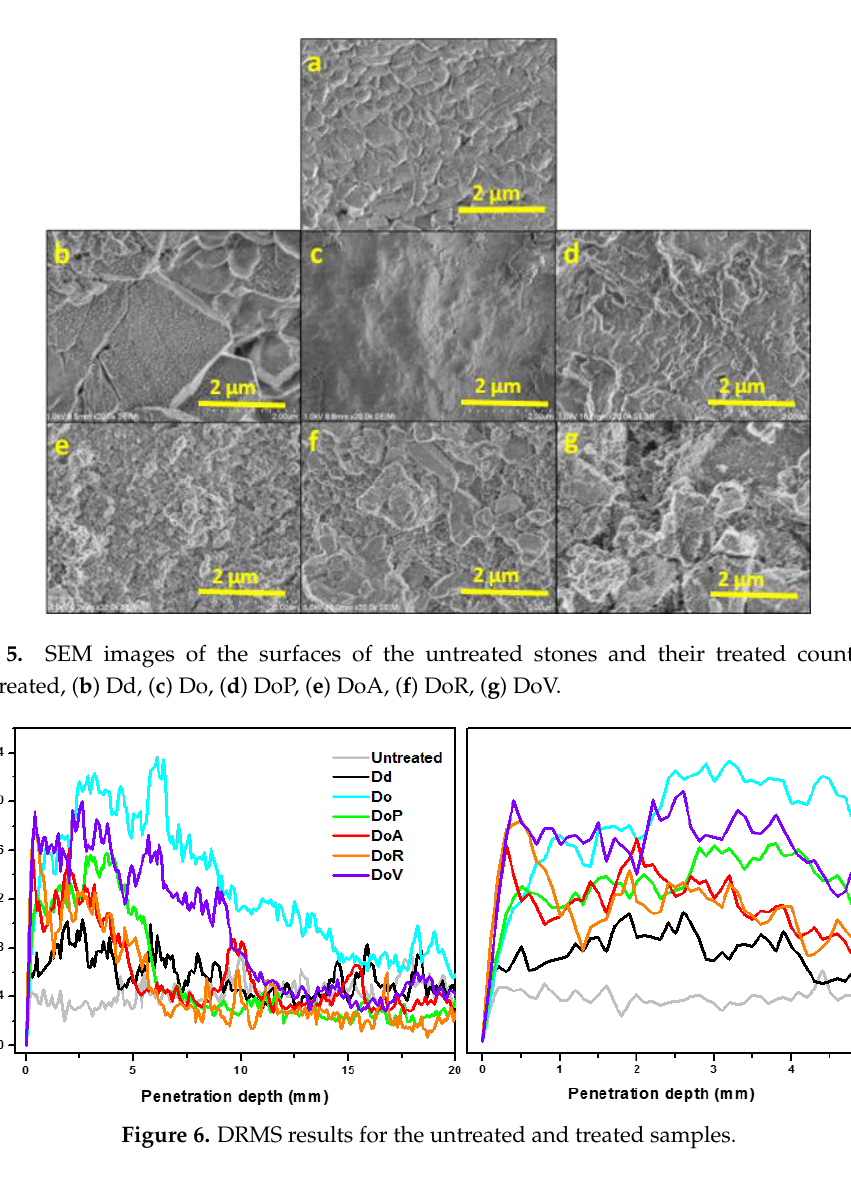
Figure 6. DRMS results for the untreated and treated samples.